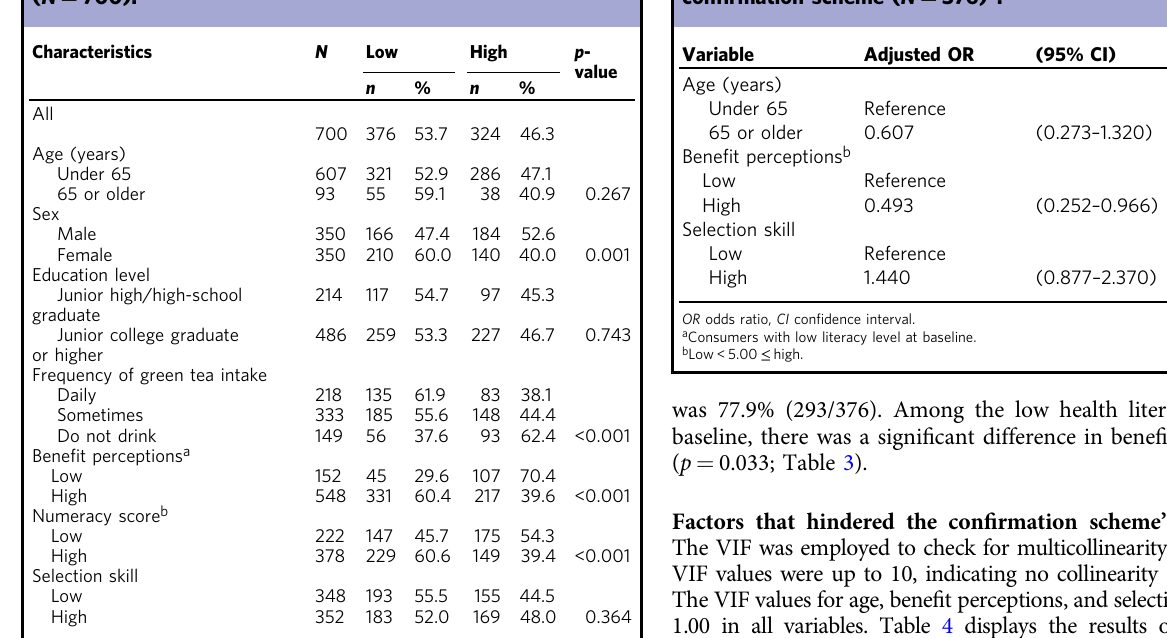
Table 2 Status of consumers ’ health literacy level at baseline ( N = 700).